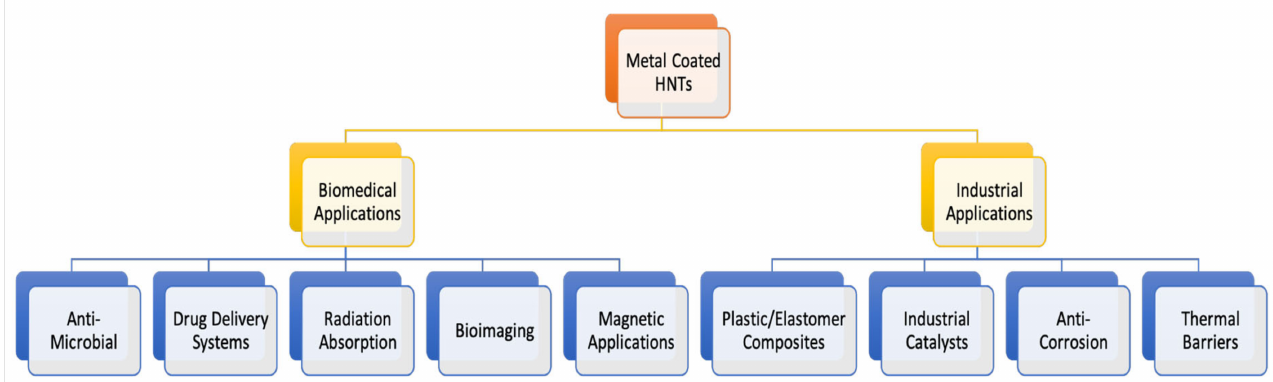
Figure 4. Application areas for metal-coated halloysite nanotubes